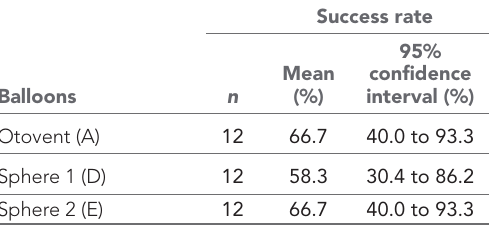
Table 4 Success rates of Otovent (A), sphere 1 (D), and sphere 2 (E) in causing a Valsalva ma- noeuvre when inflated ( n =